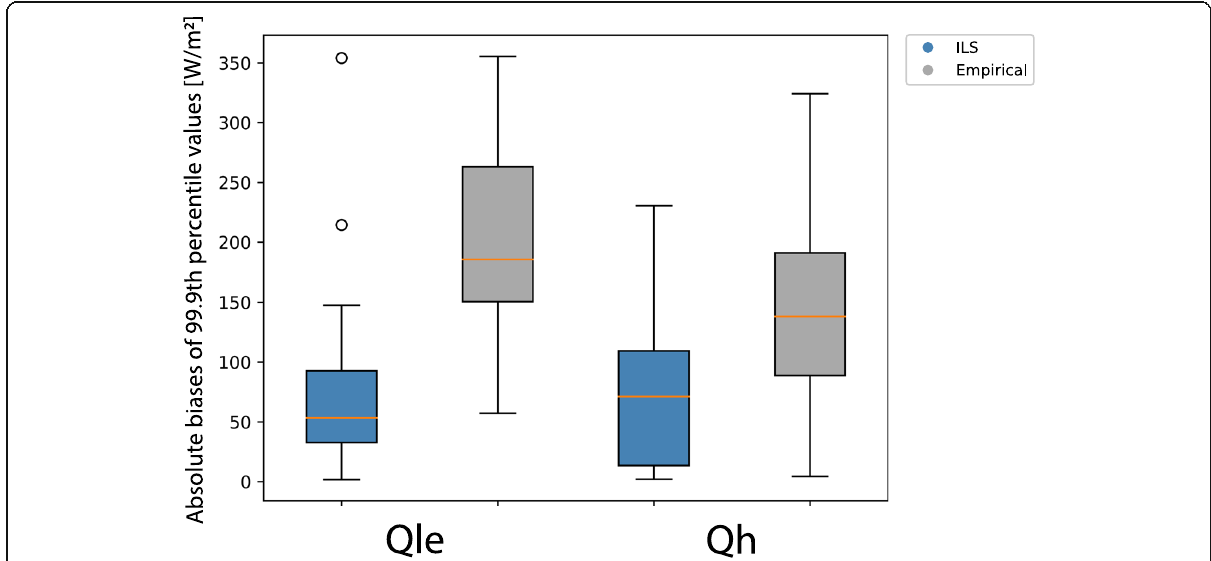
Fig. 11 Absolute biases of 99.9th percentile values of latent and sensible heat fluxes from PALS experiments. Blue shows ILS results and gray shows two-variable